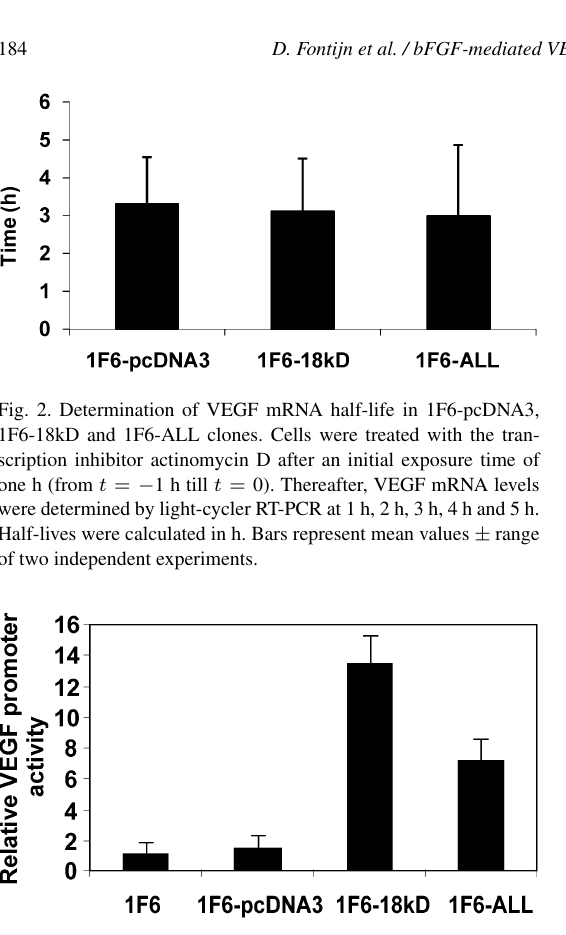
Fig. 3. VEGF promoter activity in 1F6 parent cells, 1F6-pcDNA3 and bFGF-overexpressing 1F6 clones. Cells were transiently trans- fected for 48 h with either the VEGF promoter luciferase construct VEGF-Kpn I or the promotor-less construct pGL2-basic. All cells were co-transfected with the Renilla luciferase reporter construct pRL-TK to correct for differences in transfection efficiency. Pro- moter activities are expressed relative to VEGF promoter activity in 1F6, which was set at 1. Bars represent mean values ± range of duplicate samples. The experiment was performed three times with similar outcome.